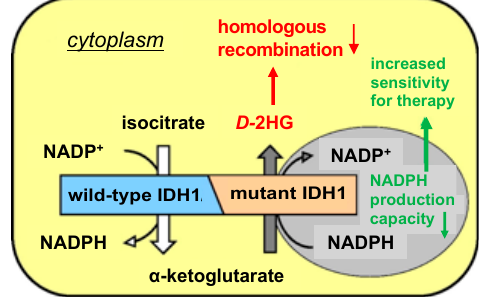
Figure 1. Schematic representation of the activity of an IDH1 WT/MUT heterodimer. The WT allele of the heterodimer produces α KG and NADPH, which are used by the mutated allele to produce D-2HG and NADP. The reduced NADPH production capacity leads to insufficient detoxification of, e.g., ROS, during irradiation and/or chemotherapy, whereas D -2HG inhibits homologous recombination, which causes increased therapeutic sensitivity.